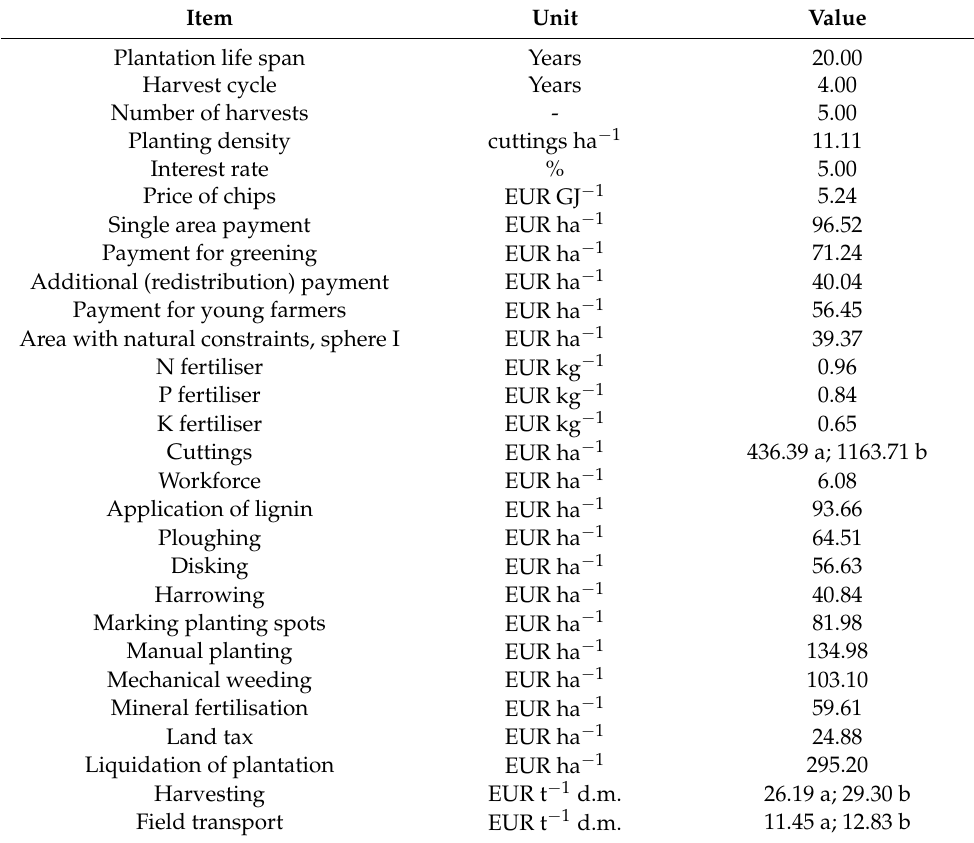
Table 1. Data on SCR production and costs used for analyses in